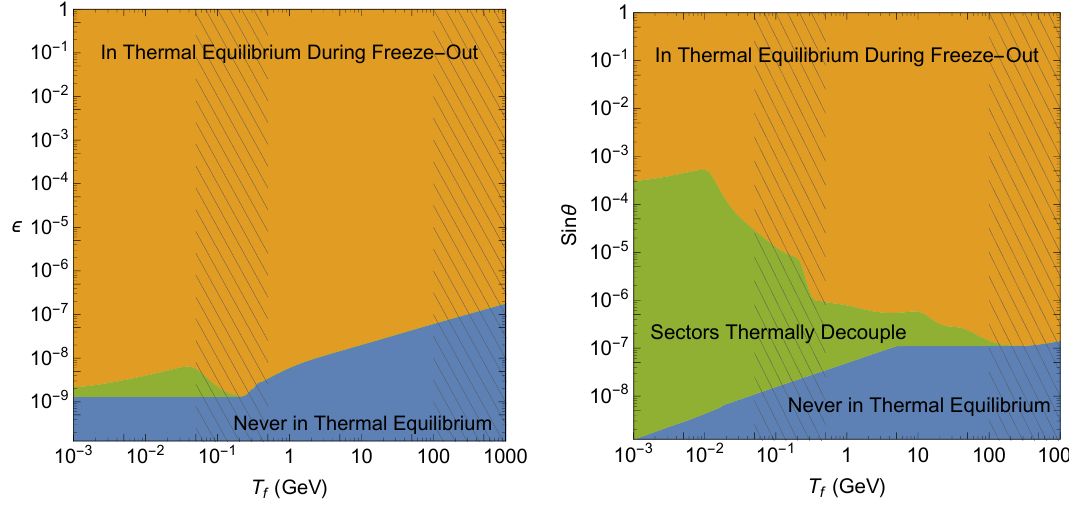
Figure 2 . Left: thermal coupling regions for the vector model as a function of the freezeout temperature, T f . The orange region is where the dark sector is in thermal equilibrium with the SM at freezeout, while the blue region has the two sectors never in thermal equilibrium. In the green region, the SM and hidden sector were in equilibrium at some higher temperature (here near the QCD phase transition), but fell out of equilibrium by T f , so that the temperatures of the two sectors may drift apart (A.11). The hatched regions are near either the chiral or electroweak phase transitions, where our calculation is less reliable. Right: thermal coupling regions for the scalar model as a function of the freezeout temperature, T f . Colors and hatching are as in the vector model. The kink in the blue region near 4 GeV is when the e(cid:11)ectiveness of the equilibration from the ss ! f (cid:22) f process near 30 GeV exceeds that from top processes near 200 GeV. For more details, see appendix